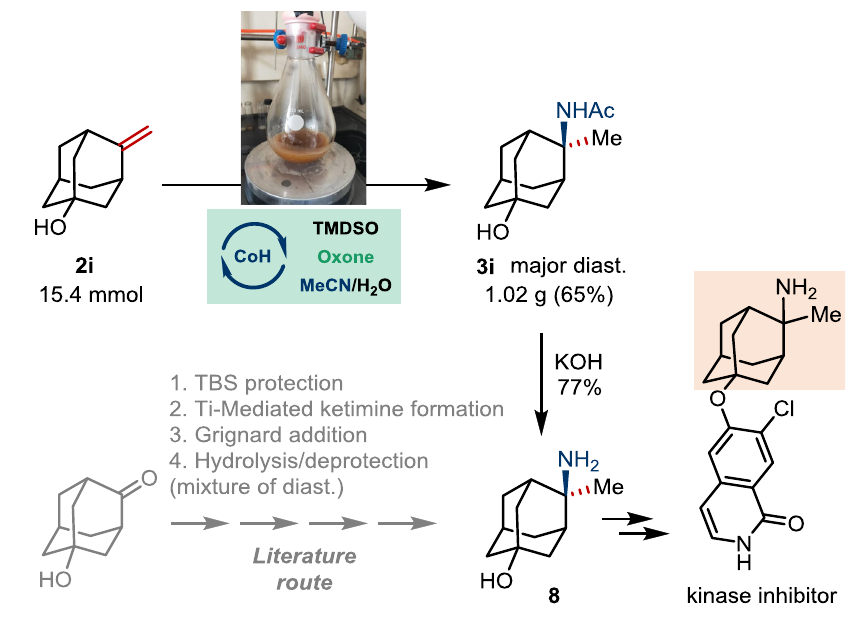
Fig. 4 Synthetic application. Gram-scale hydroamidation of 2i